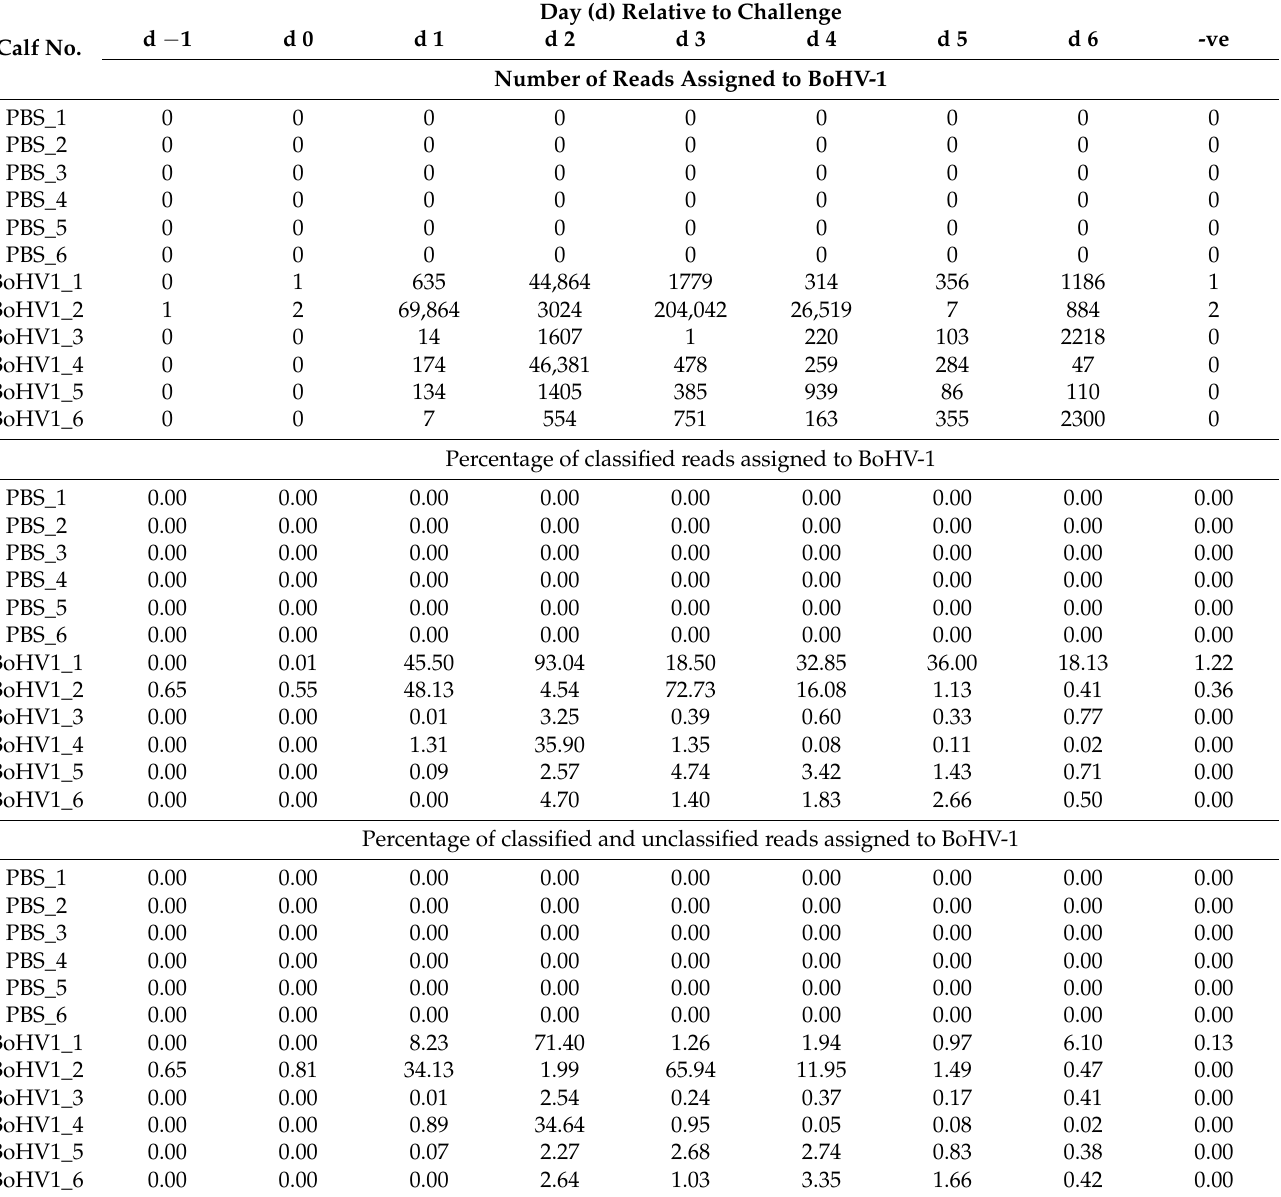
Table 4. Numbers and percentages of sequence reads assigned to BoHV-1 after MinION sequencing of nasal swabs from experimentally challenged